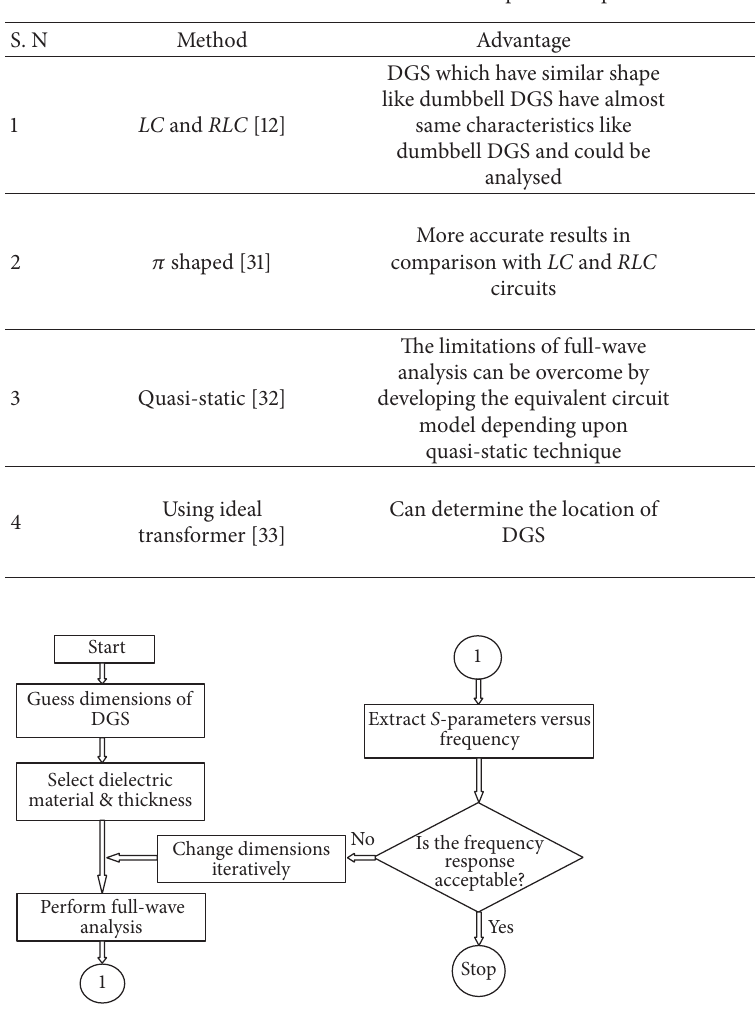
Table 3: Comparison of parameter extraction methods.